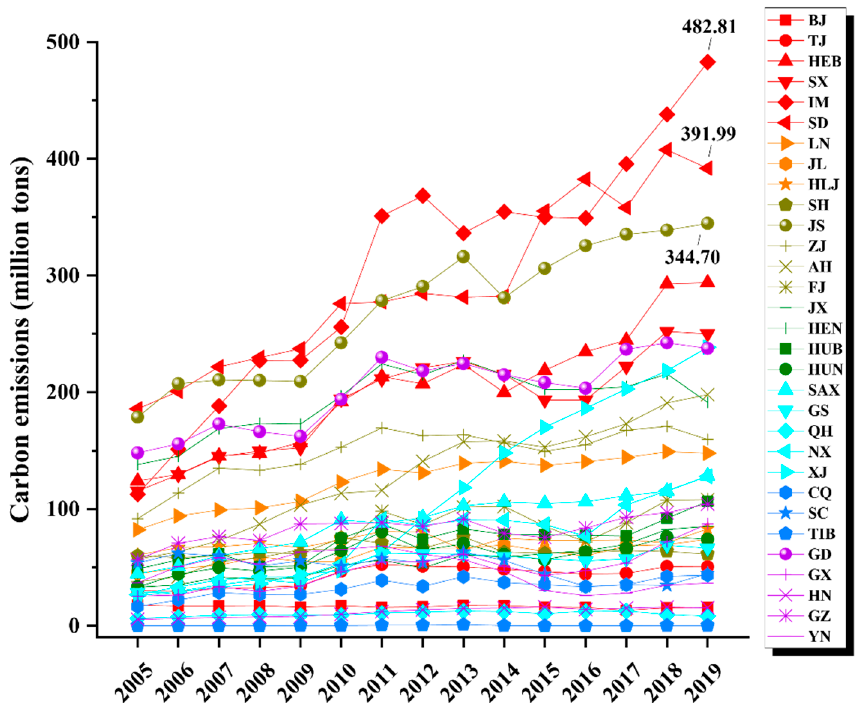
Figure 5. Carbon emissions from electricity production for each province from 2005 to 2019.